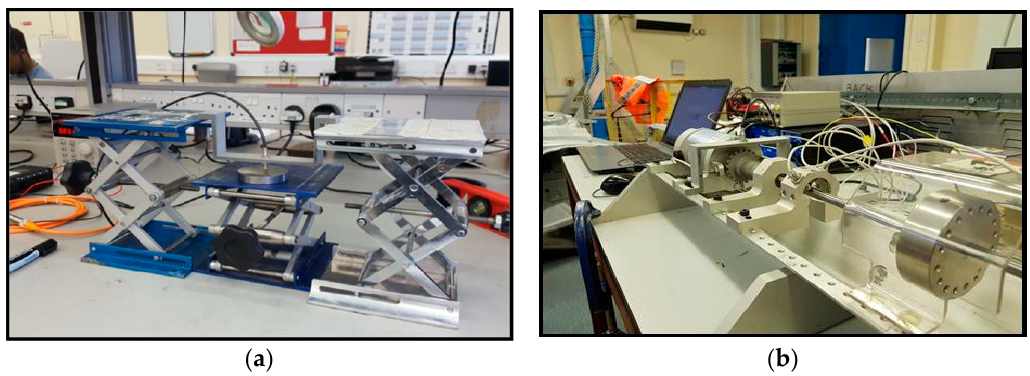
Figure 4. ( a ) Measuring calibration curve using displacement between the target and the material. ( b ) Measuring speed of the gear on Retro-dynamics test rig.